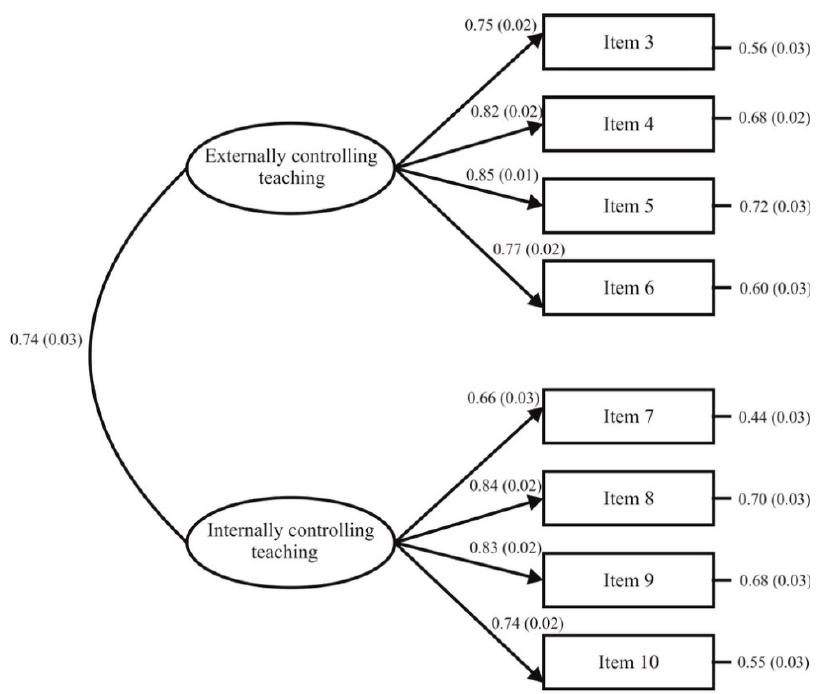
Figure 1. Results from CFA for the CTS-PE. Note : The ellipses represent each latent factor and the rectangles symbolize every item. The numbers in parenthesis show the standard error computed by bootstrapping.